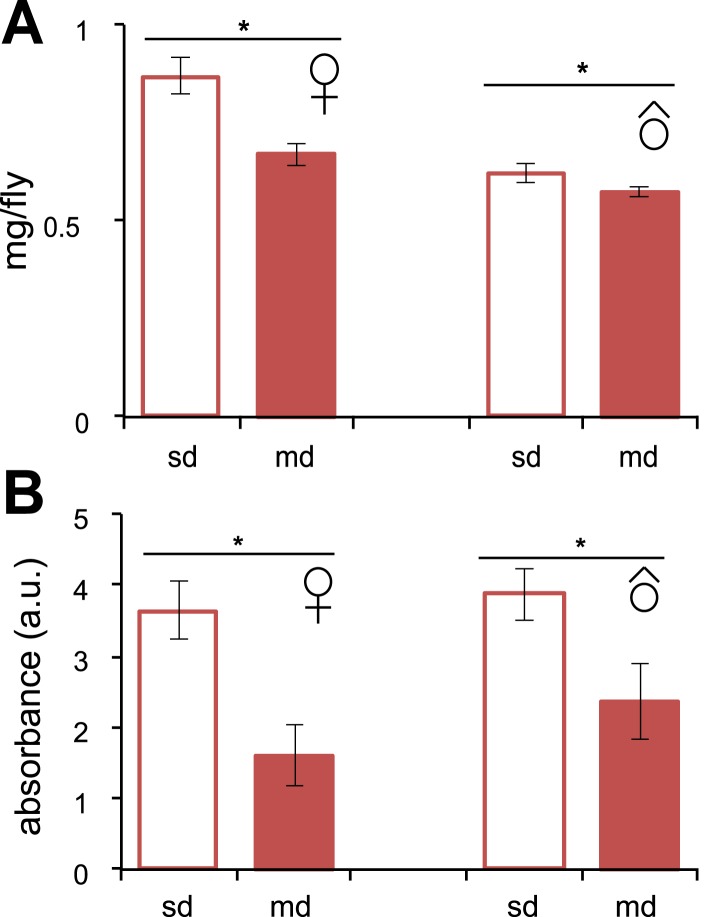
Feeding behavior in D. sechellia.(A) Individual weight (mg/fly) (N > 20) of D. sechellia (14021–0248.25) mated females and males grown on standard diet (sd) or morinda diet (md). (B) Food intake (N = 3) measured as light absorbance (a. u., arbitrary units) of ingested sulforhodamine B added to a standard diet (sd) or morinda diet (md). *p < 0.01 using Student's t test to compare diets in each group. Error bars represent s.e.m.